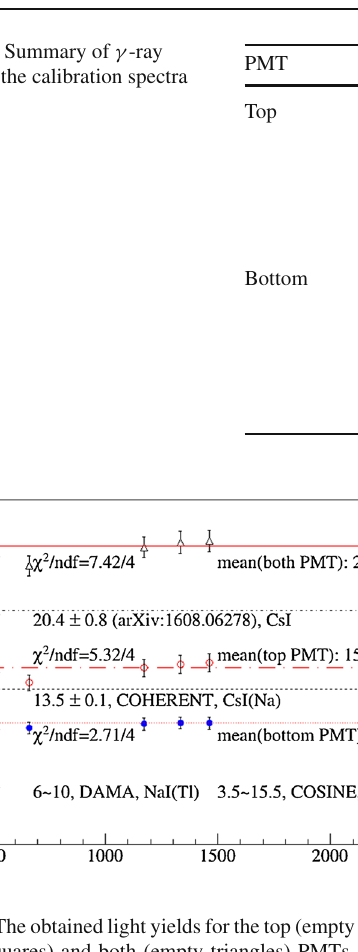
other change. The PMTs kept their yields unchanged.